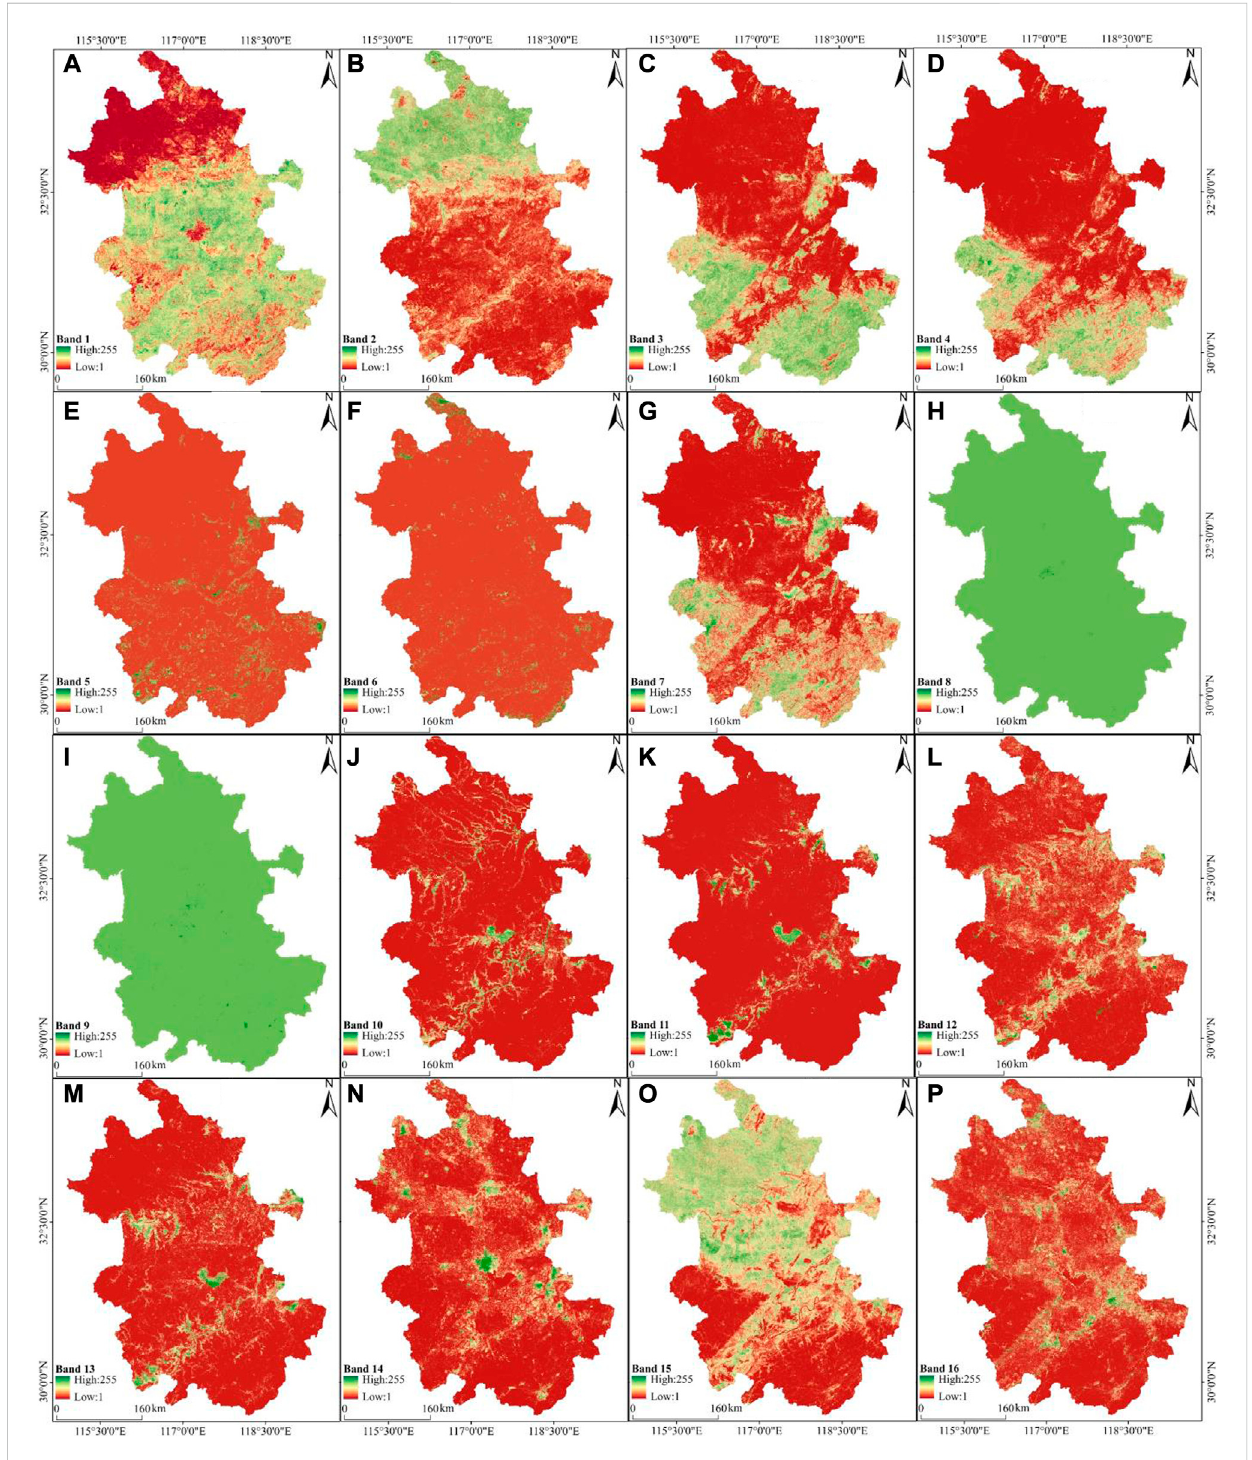
FIGURE 10 Probabilityoflandusedevelopment. (A) LanduseBand1, (B) LanduseBand2, (C) LanduseBand3, (D) LanduseBand4, (E) LanduseBand5, (F) Land use Band 6, (G) Land use Band 7, (H) Land use Band 8, (I) Land use Band 9, (J) Land use Band 10, (K) Land use Band 11, (L) Land use Band 12, (M) Land use Band 13, (N) Land use Band 14, (O) Land use Band 15, (P) Land use Band